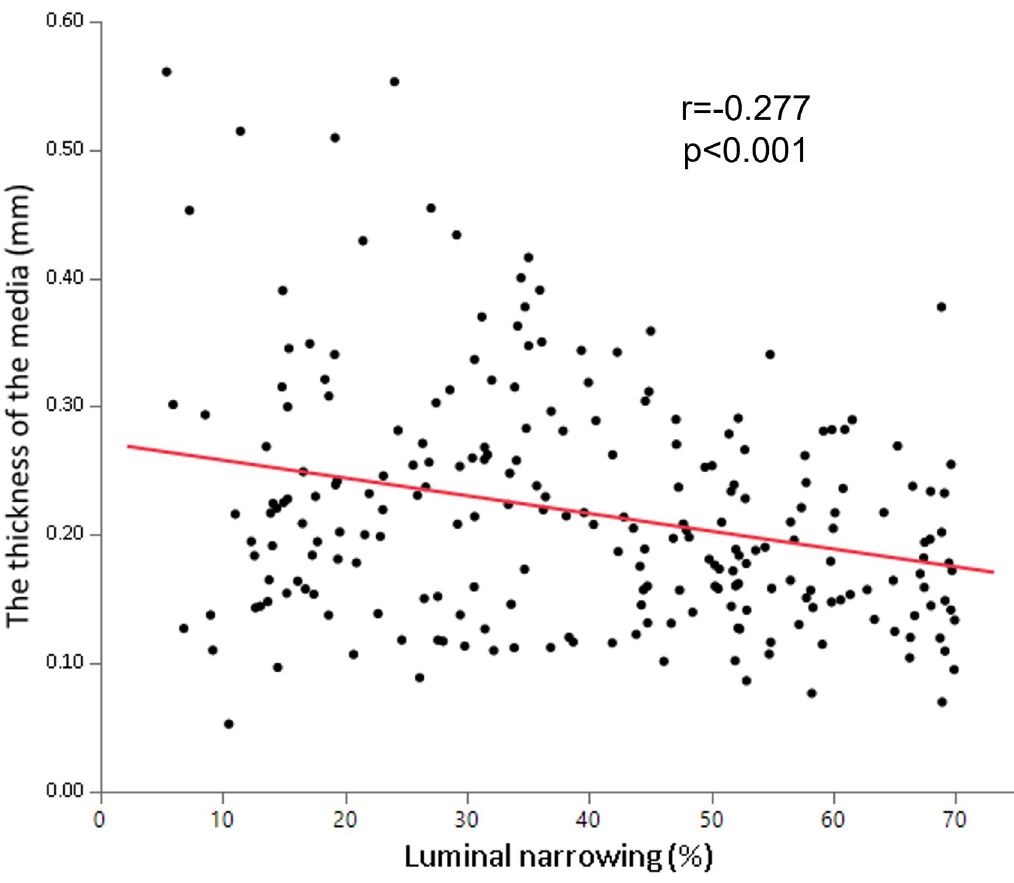
Fig 4. The relationship between the medial thicknesses and the luminal narrowing. The thickness of the media inversely correlated with the luminal narrowing (r = -0.277, p < 0.001).